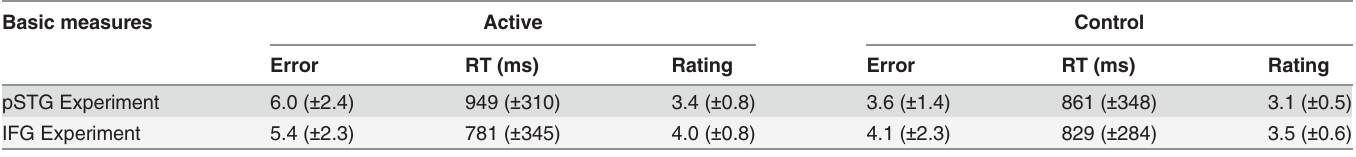
Table 1. Descriptive statistics for the basic performance measures. Basic